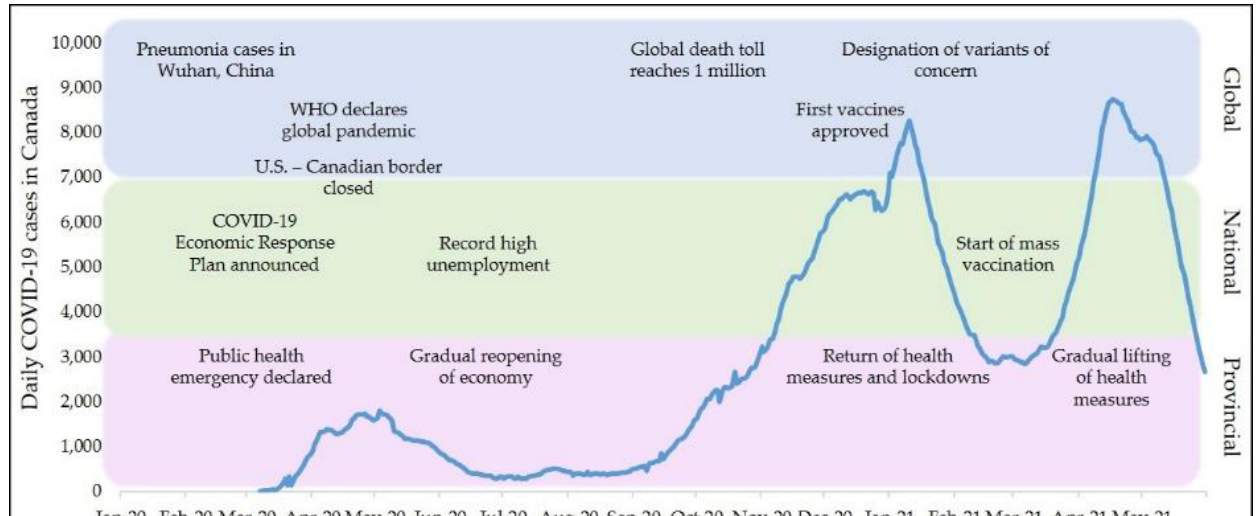
Figure 2. Timeline for the COVID-19 pandemic in Canada.